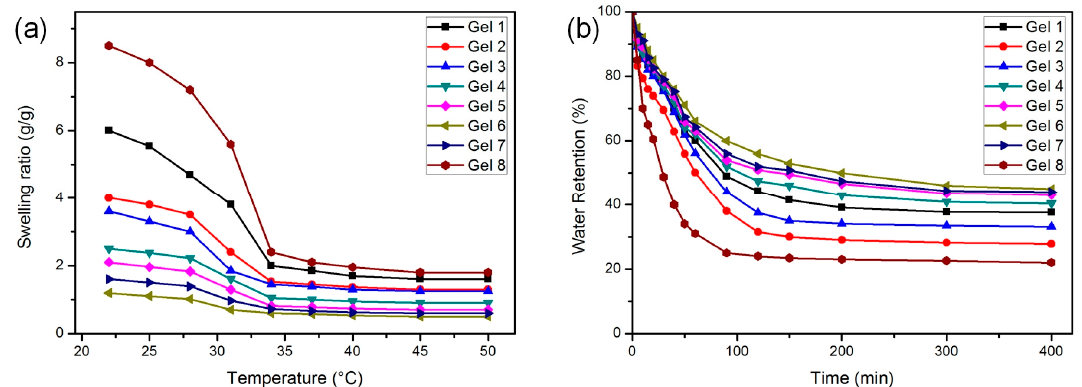
Figure 5. ( a ) The temperature-dependent swelling ratios of gels between 20 and 50 °C; and ( b ) deswelling behavior of gels at 60 °C.